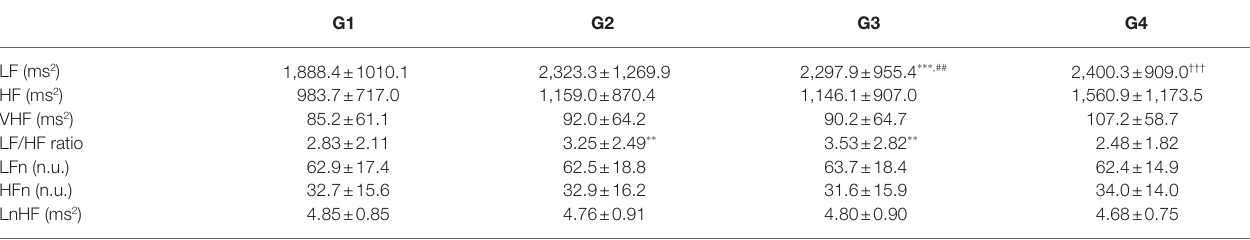
TABLE 4 | HRV frequency domain features (absolute values are means ± SD).